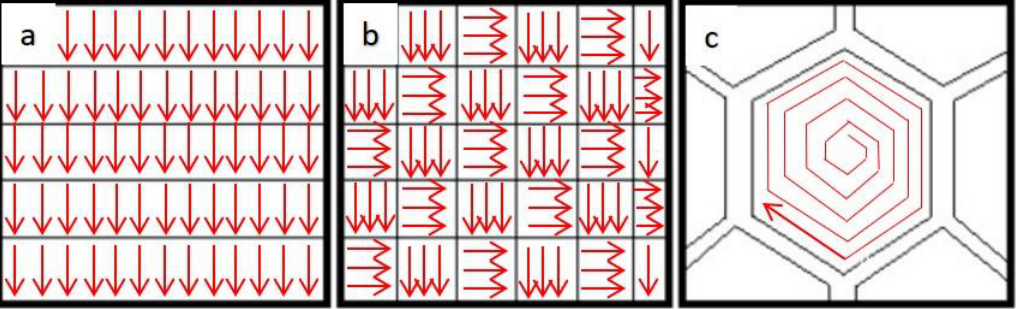
Figure 2. The three different scan patterns used in the study were ( a ) stripes, ( b ) rectangular cells, and ( c ) hexagonal cells. Table 2. Design of Experiments (DoE) for experimental trials.